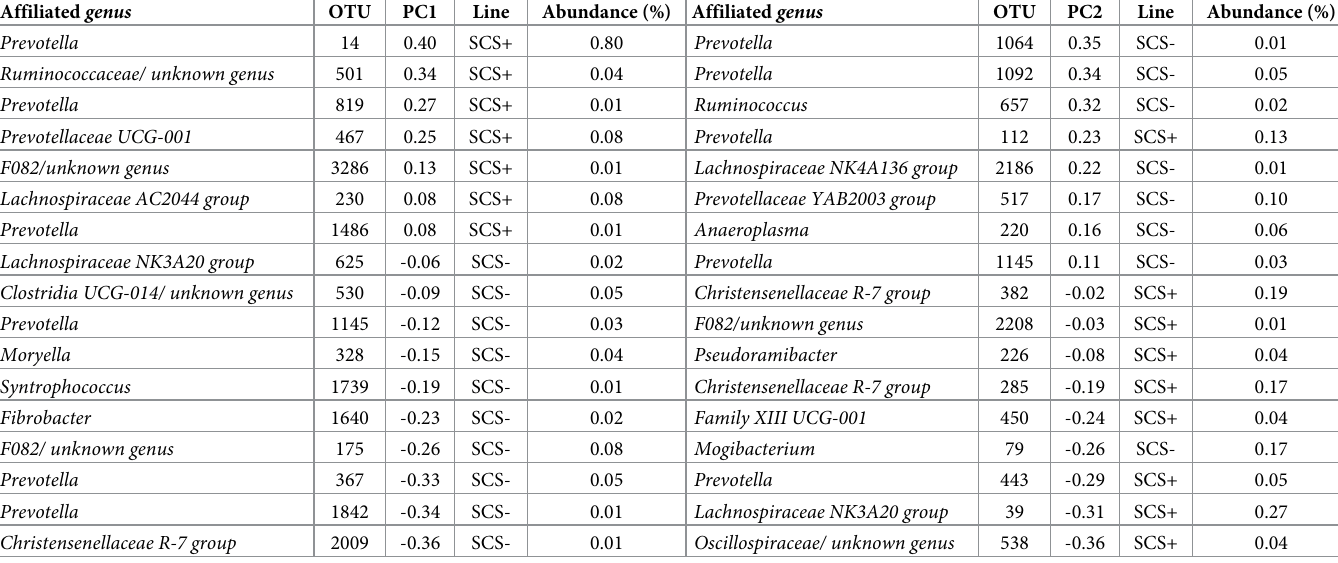
Table 1. Loading values per OTU with genus affiliation, associated genetic line and percentage of abundance, for the two first components from the somatic cell score (SCS) line sparse partial least squares discriminant